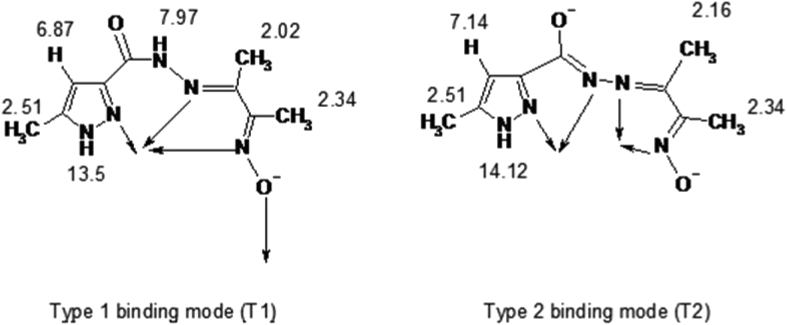
1H-NMR signals(δ) for the complex 1.